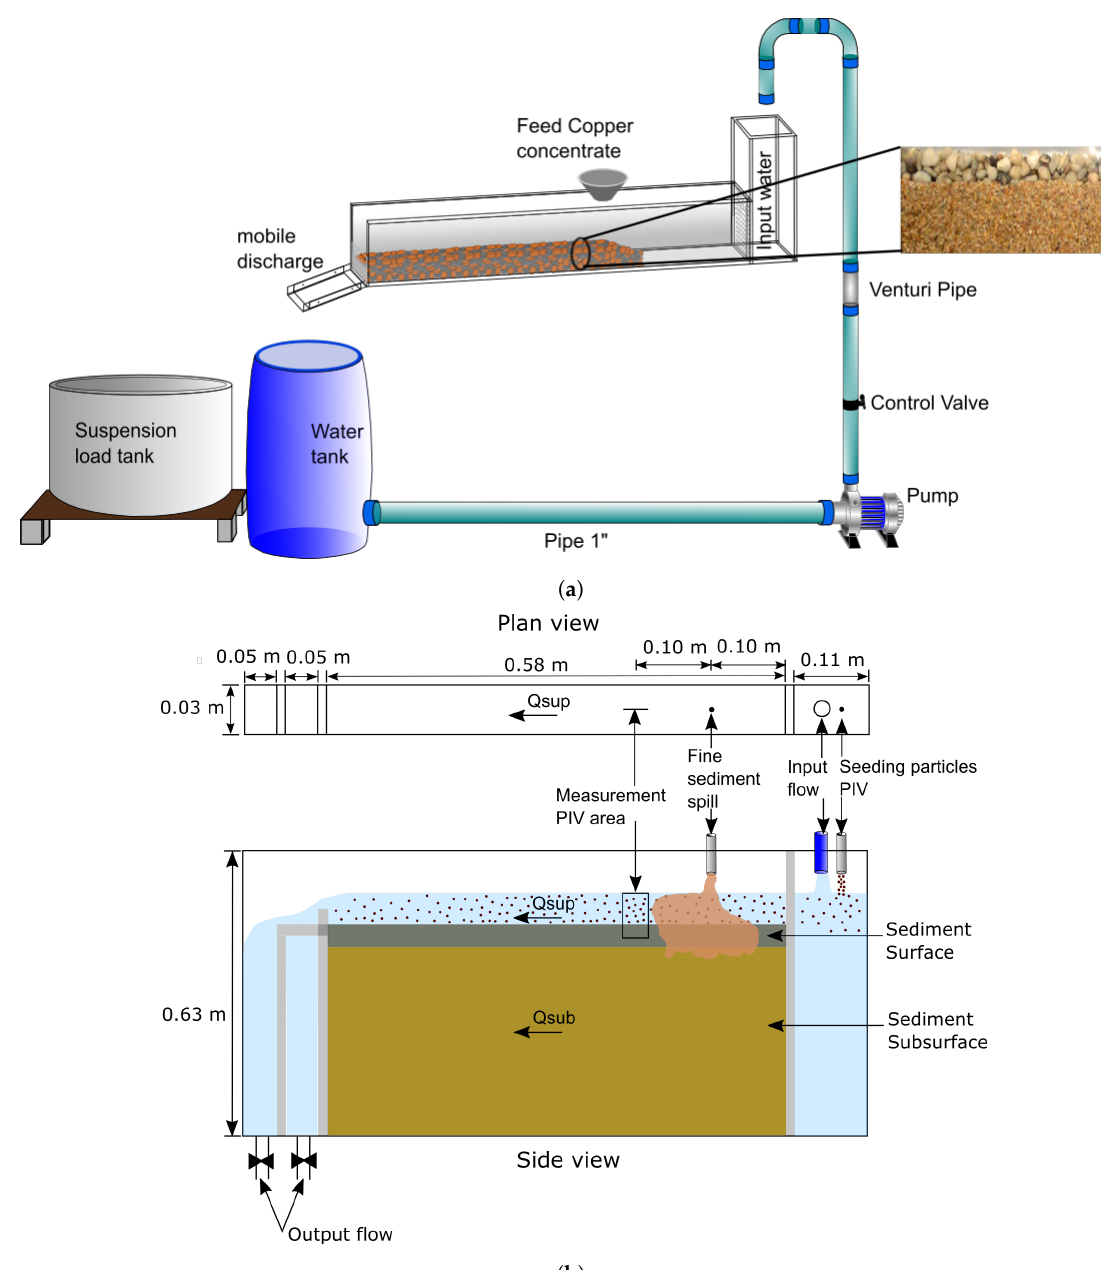
Figure 1. ( a ) Flume with water recirculation and with the possibility of diverting the flow with a chute to a tank. This experimental setup used in [25]. The arrangement of the bed is with two layers of sediments. The surface layer is composed of gravel and the substrate layer of sand; ( b ) Flume with 0.39 m of sediment thickness is used to measure high infiltrations of fine sediment and subsurface flow. The surface flow rate is Q sur and subsurface flow rate is Q sub . This experimental setup used in